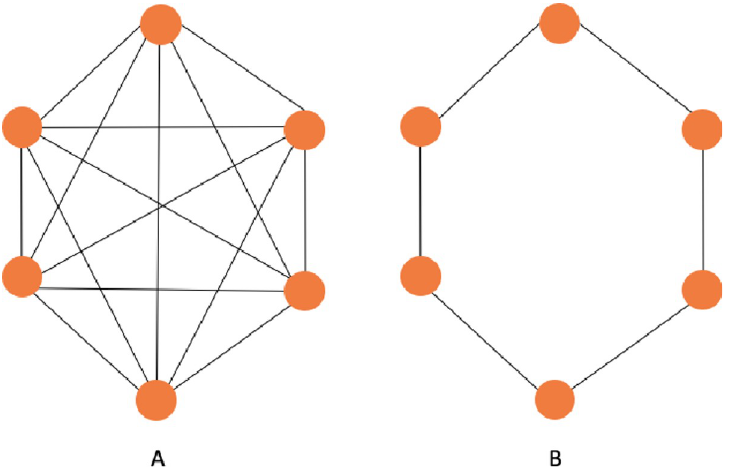
Fig 28. Edge crossing between